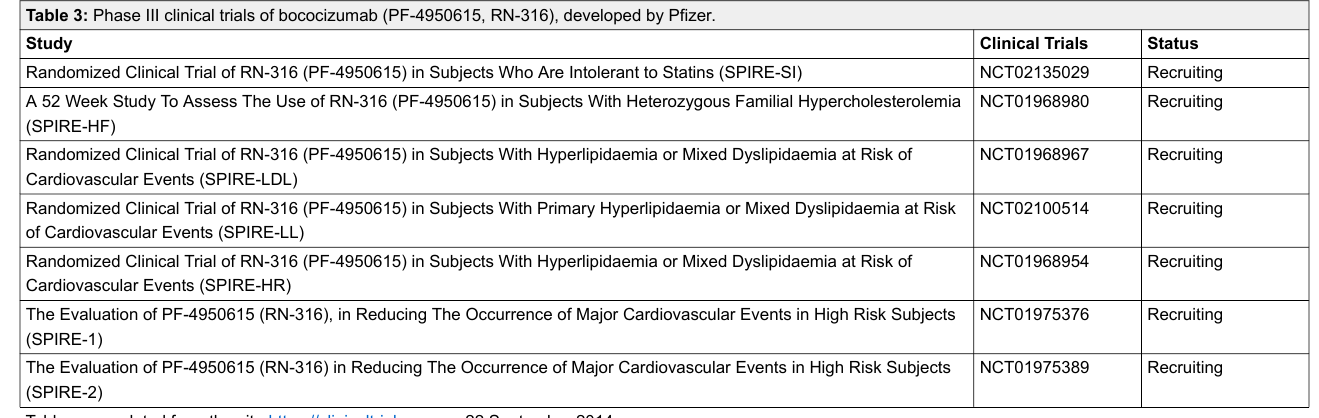
Table was updated from the site https://clinicaltrials.gov on 22 September